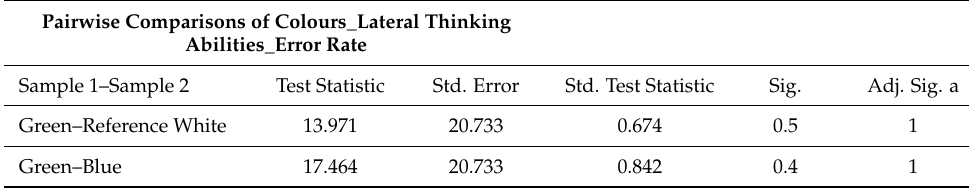
Table A16. Effects on error rate (logical thinking